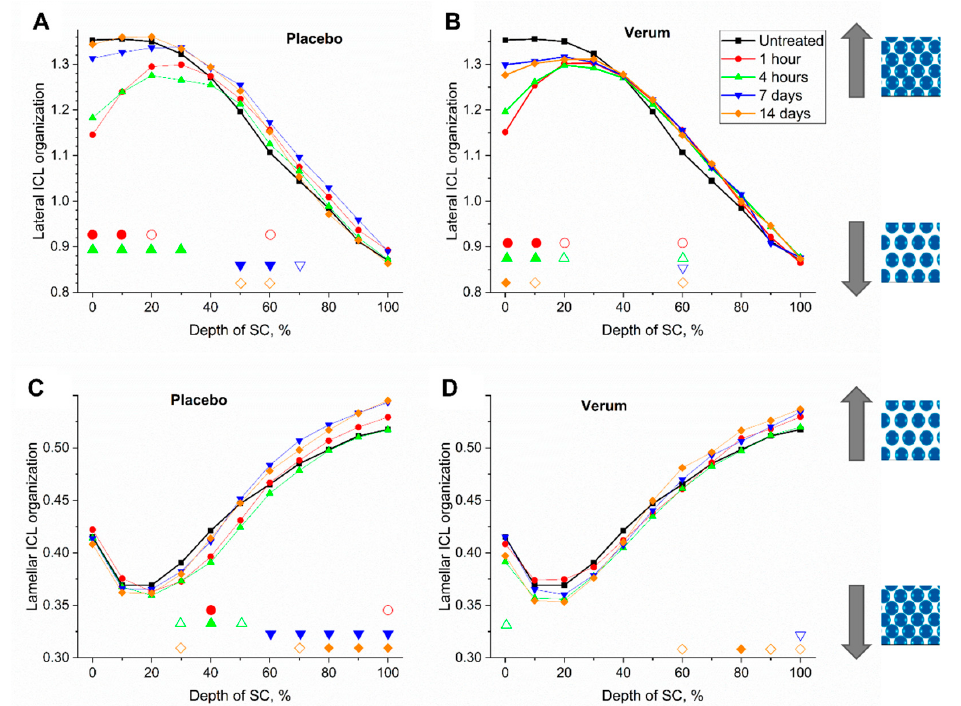
Figure 4. Mean lateral ( A , B ) and lamellar ( C , D ) organization of intercellular lipids (ICL) of all subjects before (untreated, black squares) and 1 h (red circles), 4 h (green upward triangles), 7 days (blue downward triangles) and 14 days (orange diamonds) after beginning of the treatment with the placebo ( A , C ) and verum ( B , D ). The signals are normalized to the thickness of the SC (0–100%). Significant differences ( p < 0.05) are marked below in empty shapes, strongly significant differences ( p < 0.01) in solid shapes.